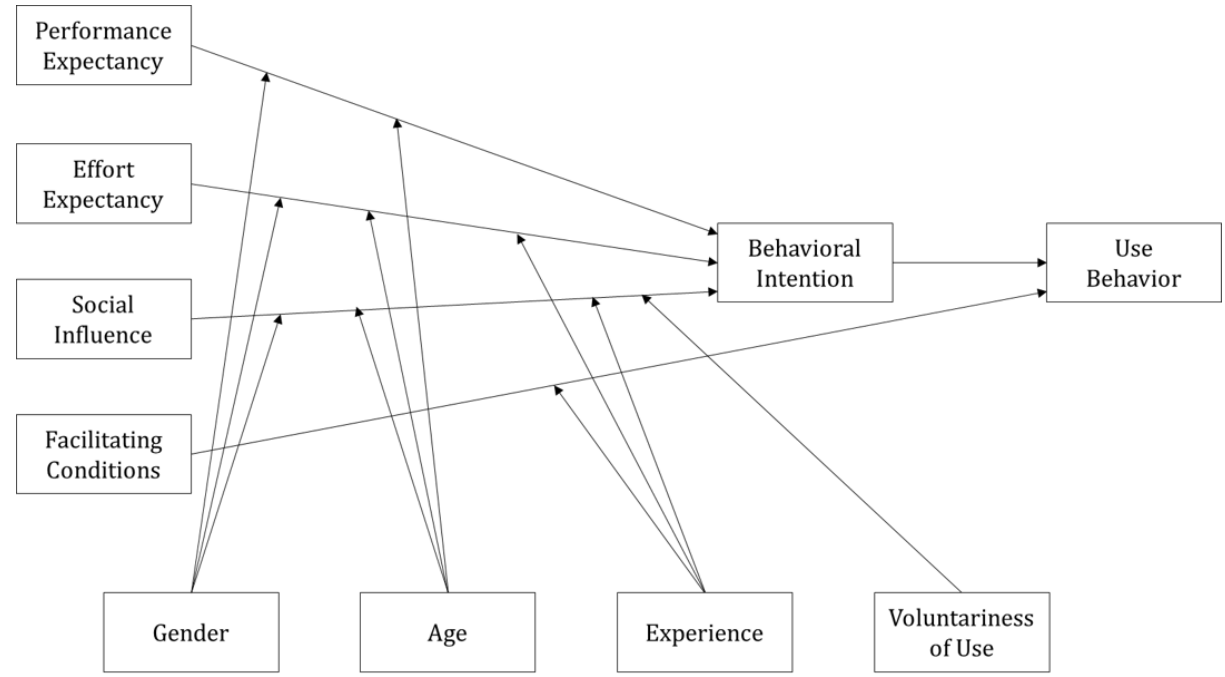
Figure 1. Unified theory of acceptance and use of technology